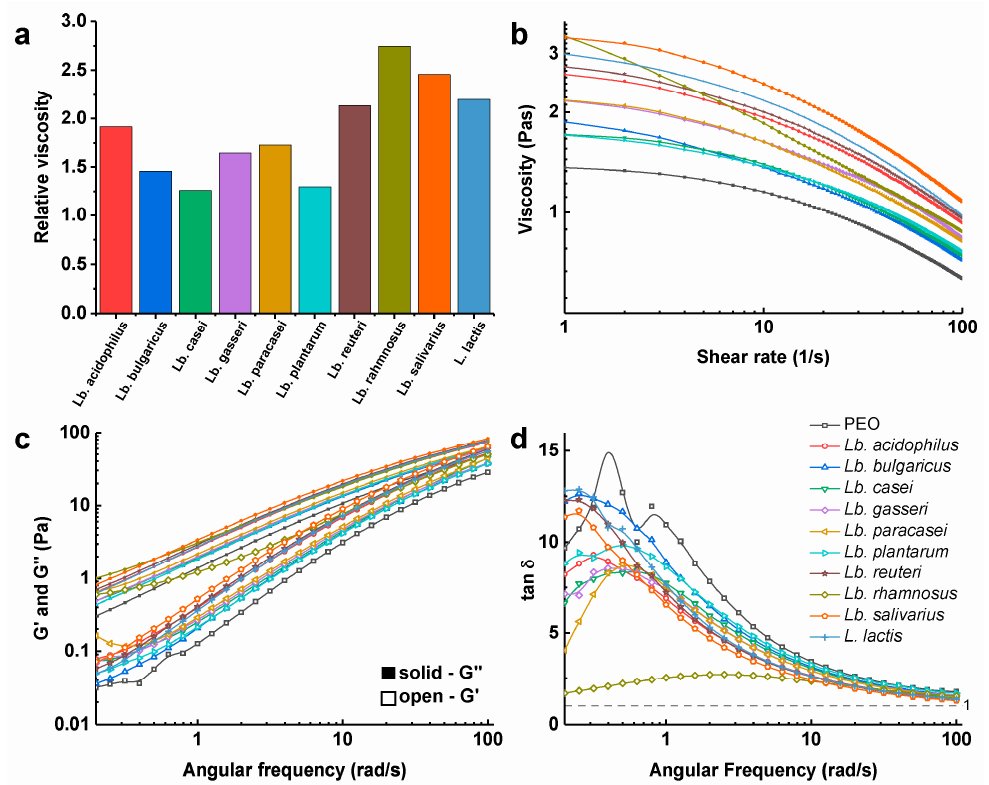
Figure 2. Rheological characterization of 4% ( m/v ) poly(ethylene oxide) (PEO) solutions without bacteria and with the dispersed Lactobacillus spp. or L. lactis . ( a ) Relative viscosity, as the ratio of the viscosity of the PEO dispersions with bacteria to that of the PEO solution, at a 1 /s shear rate. ( b ) Viscosity of the dispersions as a function of the shear rate. ( c ) Storage (G’) and loss (G”) moduli, and ( d ) tan δ as a function of the angular